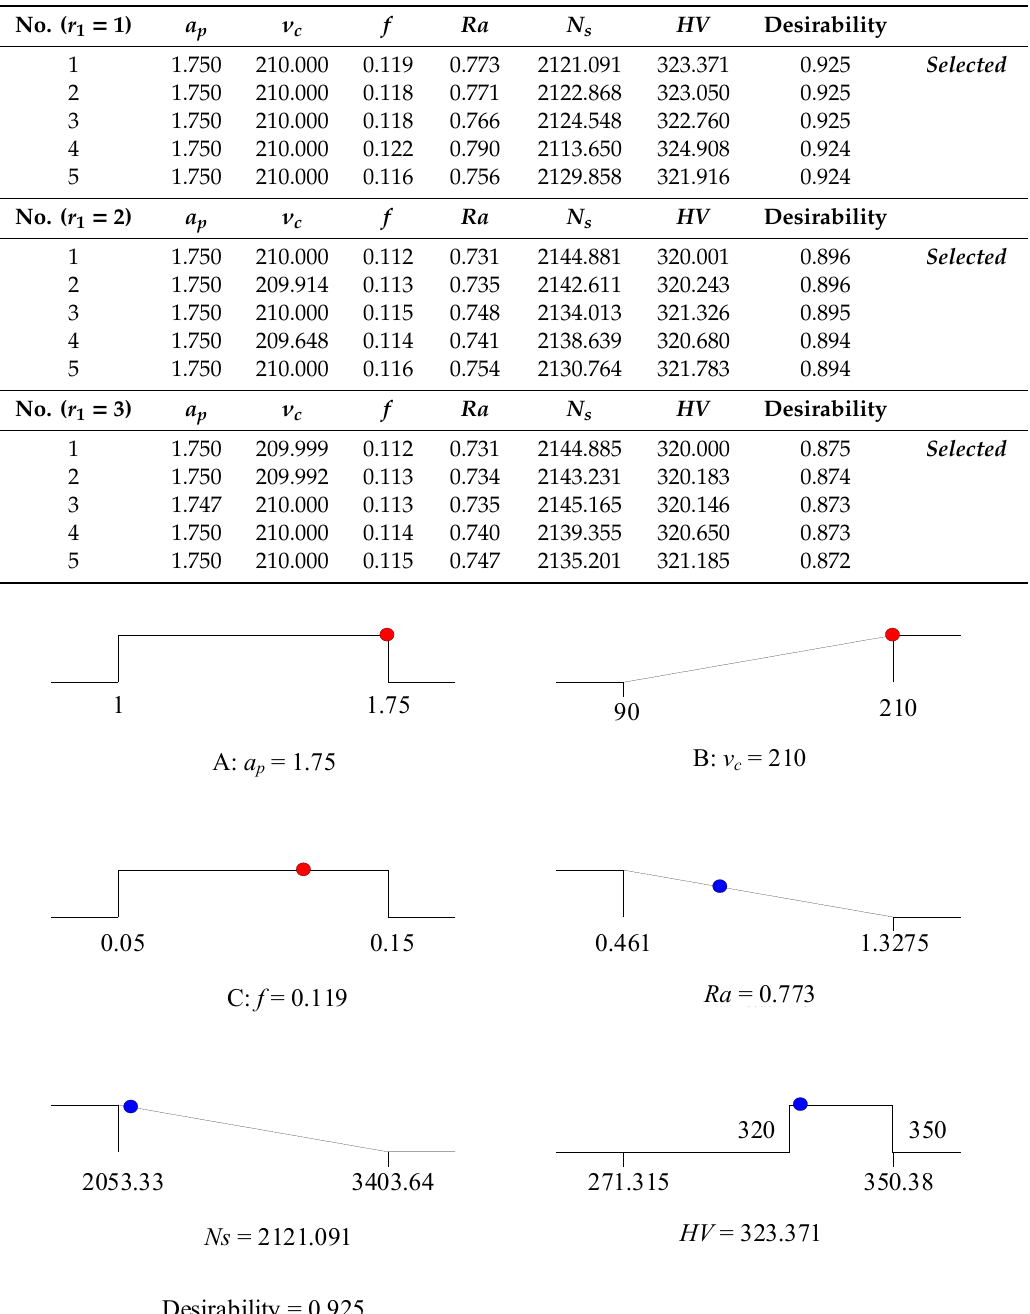
Table 10. Multi-objective optimization solution (low energy consumption (LEC) mode).